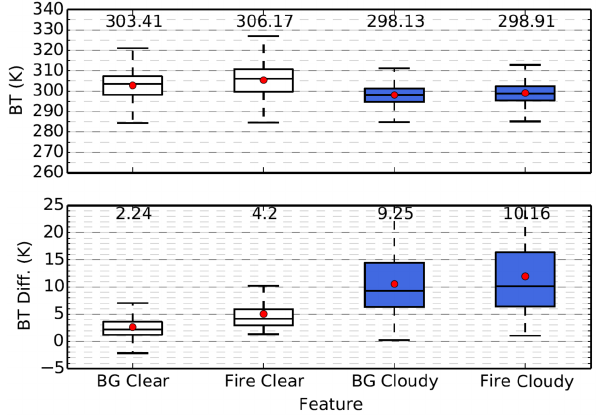
Figure 5. Examination of signals from fires burning under clear sky and thin cloud, along with their background (BG) windows. Potential fire pixel (Fire) and BG signal box plots for IR3.9 BT and IR3.9–IR10.8BT differences calculated using 5 days of SE- VIRI daytime data (8–12 August 2014) over Southern Africa. The box plot follows standard conventions, with the bar representing the median and the red dot the mean. The figure above each box plot reports the actual median